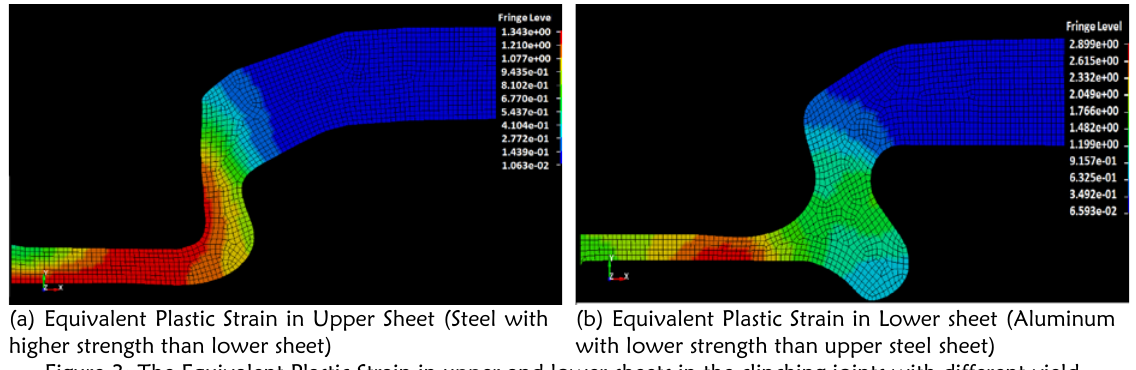
Figure 3: The Equivalent Plastic Strain in upper and lower sheets in the clinching joints with different yield strength